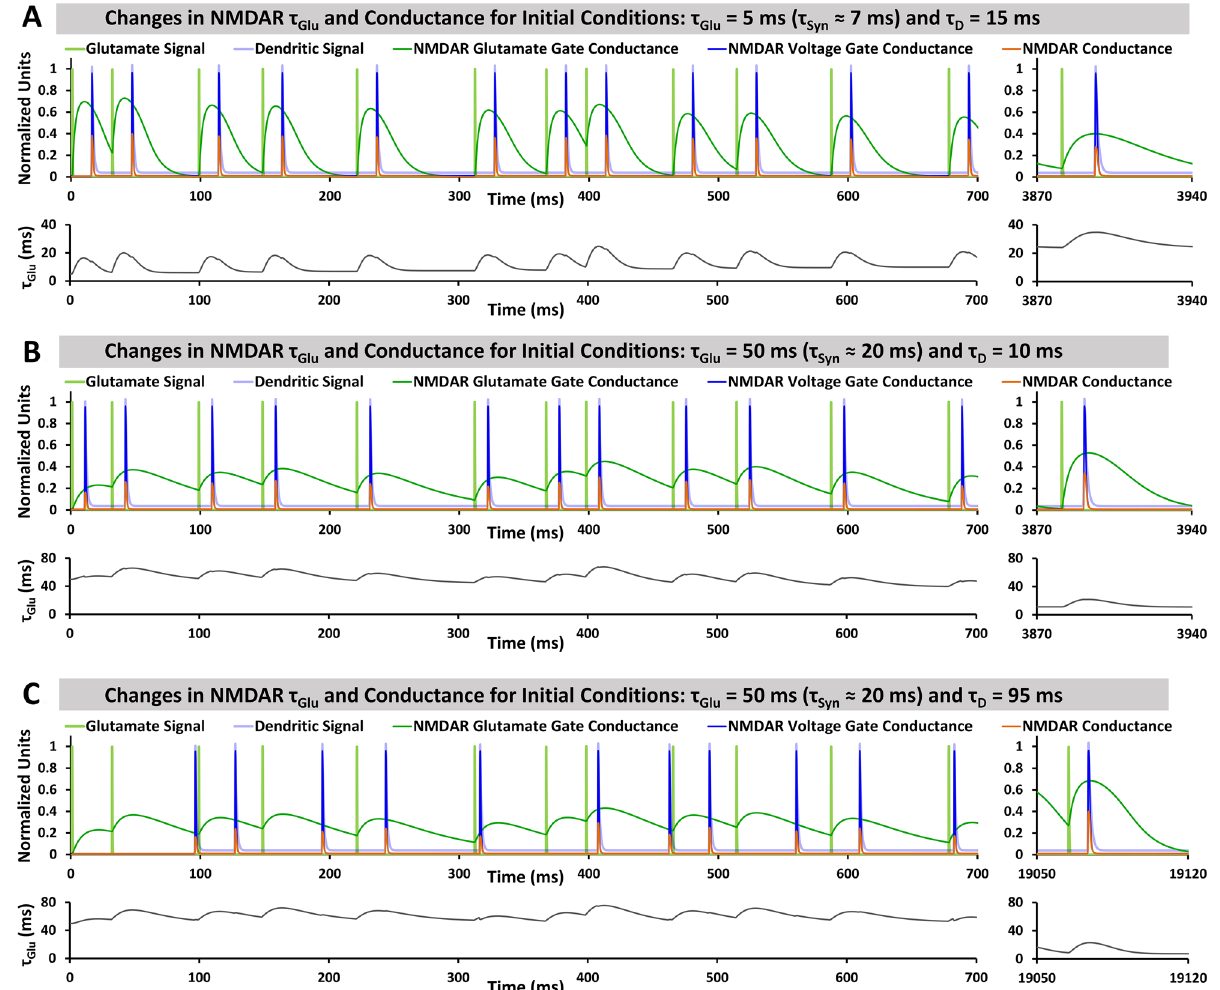
Figure 2. SITDL simulations of a single synapse receiving periodic inputs and showing evolution of τ Glu and conductances for different initial conditions of τ Glu and τ D . In each case, the synapse receives a synaptic glutamate signal (light green) followed by a dendritic voltage signal (light blue) delayed by time τ D . τ Glu changes over time due to the NMDAR gate conductance mismatch. ( A) Simulation with initial values τ Glu = 5 ms and τ D = 15 ms. Initially, glutamate gate conductance, g Glu , peaks before voltage gate conductance, g V . Over time, τ Glu grows, delaying the g Glu peak and achieving greater coincidence. ( B) Simulation with initial values τ Glu = 50 ms and τ D = 10 ms. In this case, g V initially peaks before g Glu . τ Glu decreases over time, resulting in greater coincidence of the gate conductances. ( C) Simulation with initial values τ Glu = 50 ms and τ D = 95 ms.